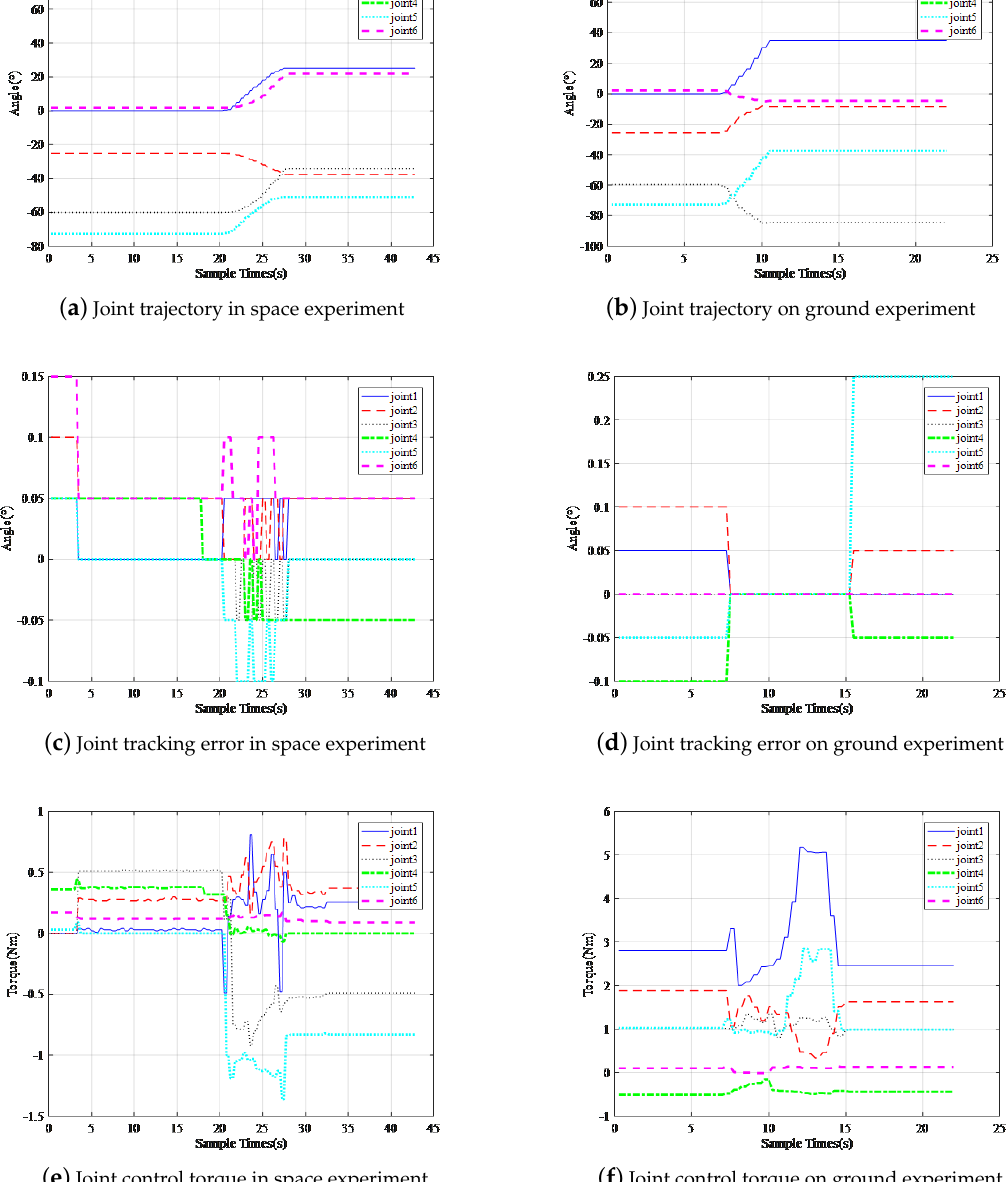
Figure 11. ( a , b ) represent the trajectories of the end of the manipulator in space and on the ground, respectively. As described above, the ground simulation experiment is guided by offline programming of the industrial robot. Therefore, the trajectories are not completely consistent with those in the space experiment, but the experimental results are not affected. ( c , d ) show the joint angle errors in the acquisition task. It can be seen that the errors are controlled in a small range. Within this range, ( e , f ) show the joint moment in the capture task. In the ground experiment, the joint moment is markedly larger than that in the space